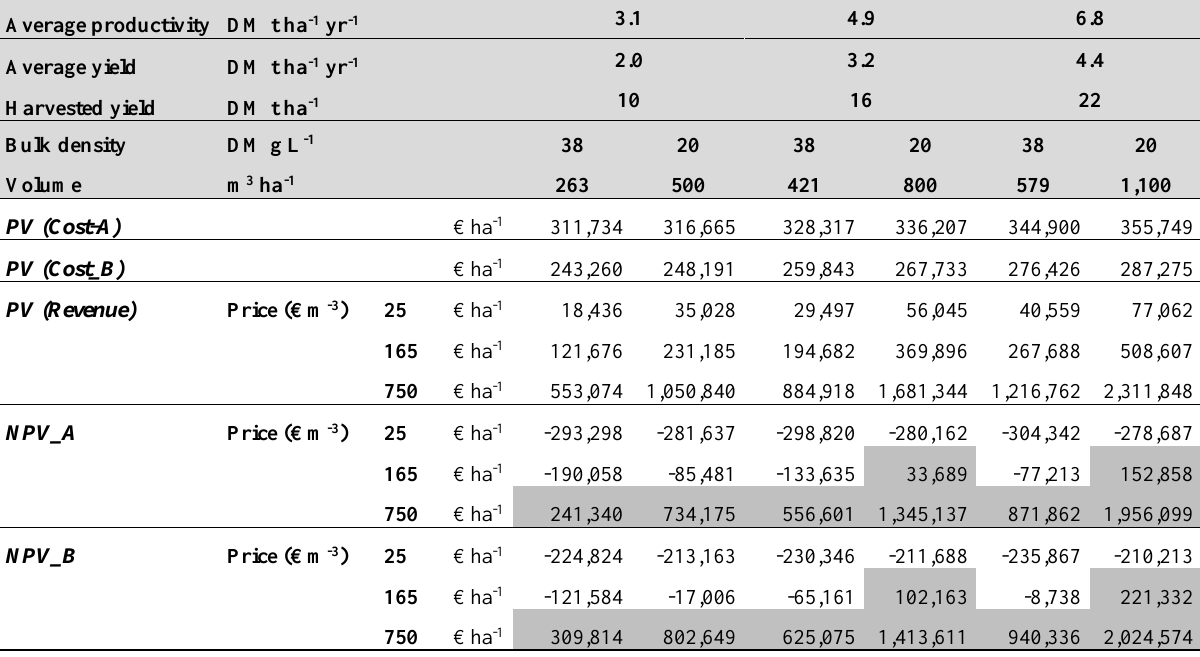
Table A4. Present Values ( PV ) of Sphagnum farming at high costs (Scenario A) and medium costs (Scenario B) at different levels of harvested yield, bulk density and price (DM = dry mass). Highlighted cells indicate positive Net Present Values ( NPV ), i.e. profitable